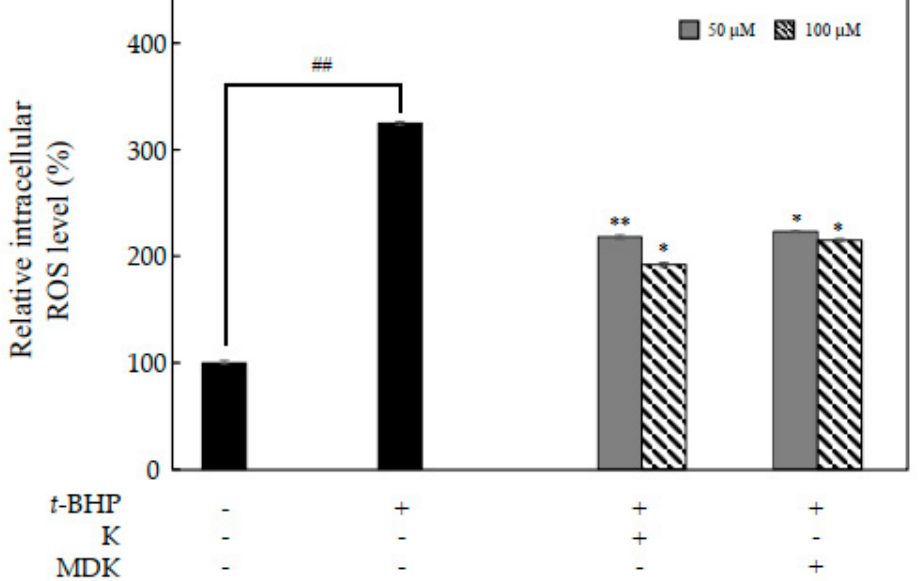
Figure 5. Effects of K and MDK on intracellular ROS generation in t -BHP-treated B16F10 cells. The data are represented as the mean ± SD (n = 3) of three individual experiments. ## p < 0.01 vs. non-treated group; * p < 0.05 and ** p < 0.01 vs. t -BHP-treated group.